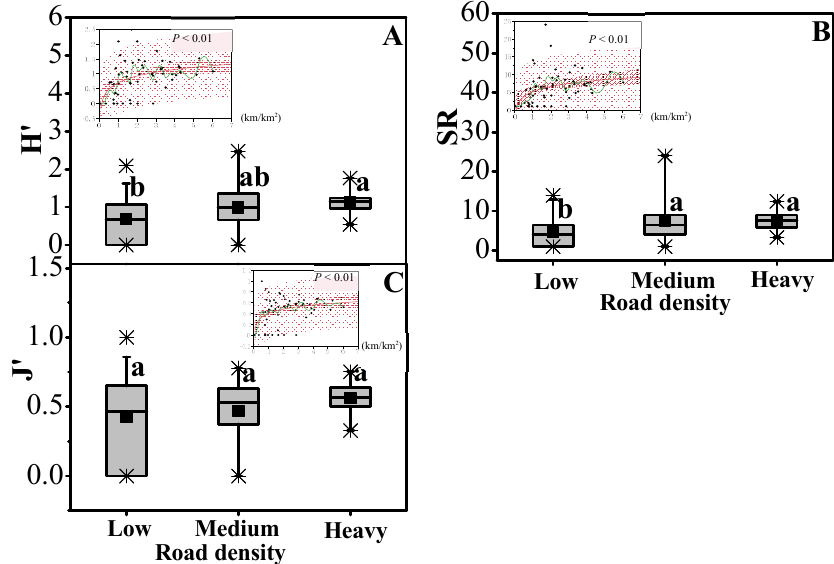
Figure 6. Taxonomic attributes at different road densities (RD). ( A ) Shannon Wiener diversity index (H’), ( B ) species richness (SR), and ( C ) evenness index (J’). The boxplots show the mean (black square), median (black line in the box), inter-quartile range (25%–75% in the box), and the range of normal values (the whisker). The mean values sharing different letters are significantly different ( p < 0.05), and the different letters at different RD regions are significantly different in their arithmetic means ( p < 0.05). The figure insets depict significant regression lines from the raw data. The red line is the regression line, and the green lines represent the moving mean value. The dual-shaded shadows represent the best-fitting and predicted interval ranges. Table 3. The relationships between landscape metrics, structural-taxonomic attributes, and road densities (RDs) measured as road density fractions.